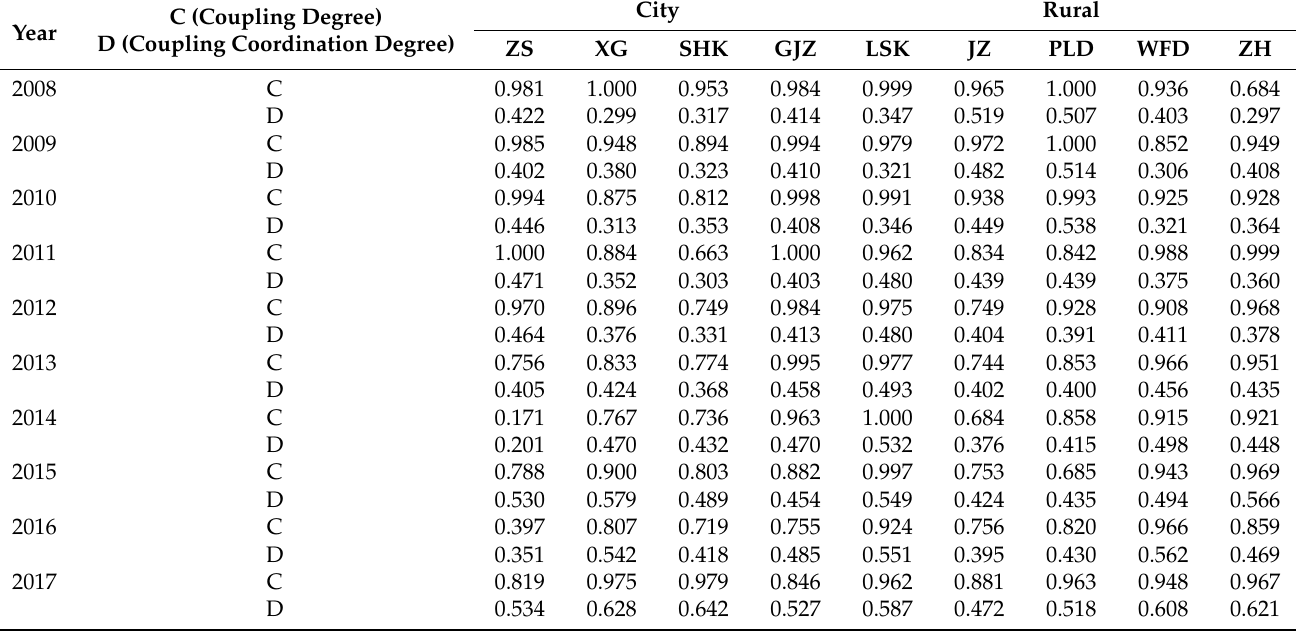
Table 6. For the coupling degree and coordination degree of different